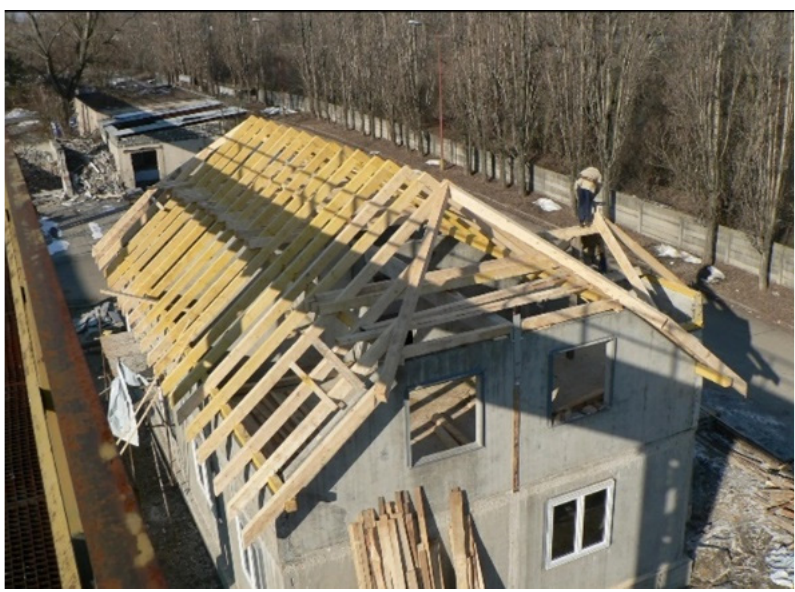
Figure 29. View of the realization of the wooden truss (photo archive: Kalús, D.)